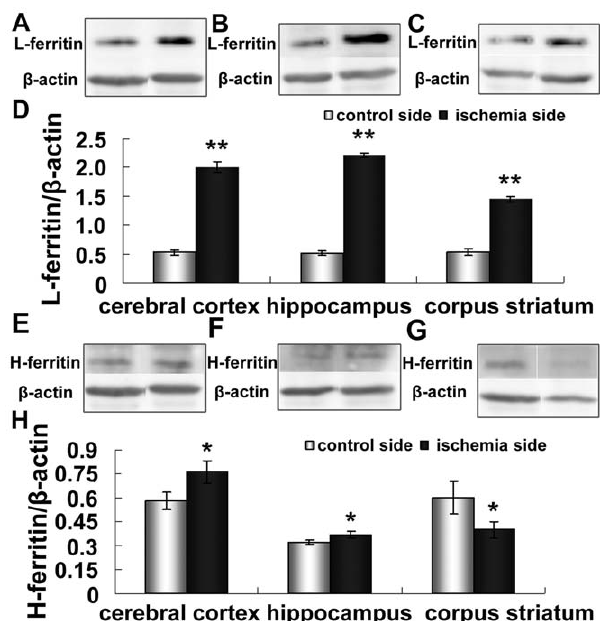
Figure 1. Expression of L-ferritin and H-ferritin in ischemic brain. Rats were subjected to 60 min MCAO and 24 hour reperfusion. Contralateral and ipsilateral cerebral cortex (A,E), hippocampus (B,F) and corpus striatum (C,G) were isolated, homogenized, and analyzed for L- and H- ferritin by Western blotting. Representative ferritin blots and corresponding b -actin blots are shown on the top panel. The lower panel (D, H) shows the summary of L-ferritin and H-ferritin expression levels from three animals in each group. Results are presented as Mean 6 SEM, n=3. **p , 0.01 v.s. contraleteral side, *p , 0.05 v.s. contralateral side.